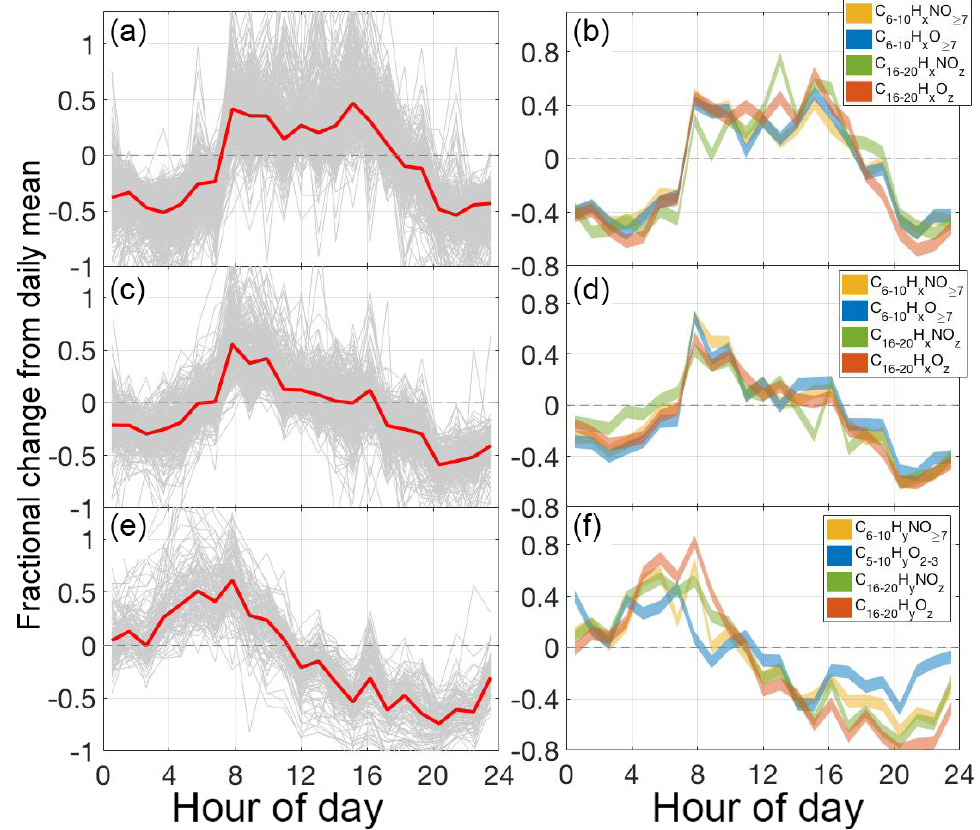
Figure 5. Same as Fig. 4, but for the particle phase. The nighttime subgroup of the particle phase was dominated by ON species. Only four OC compounds with 10 or less carbon atoms exhibited a nighttime diel trend and all possess 3 or less oxygen atoms, as shown (f) in